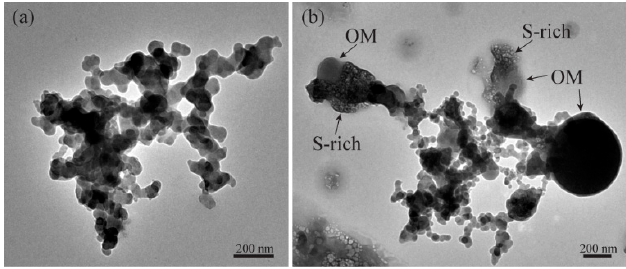
Figure 4. TEM images of soot particles. ( a ) Bare soot particle; ( b ) soot internally mixed with S-rich and OM particle.